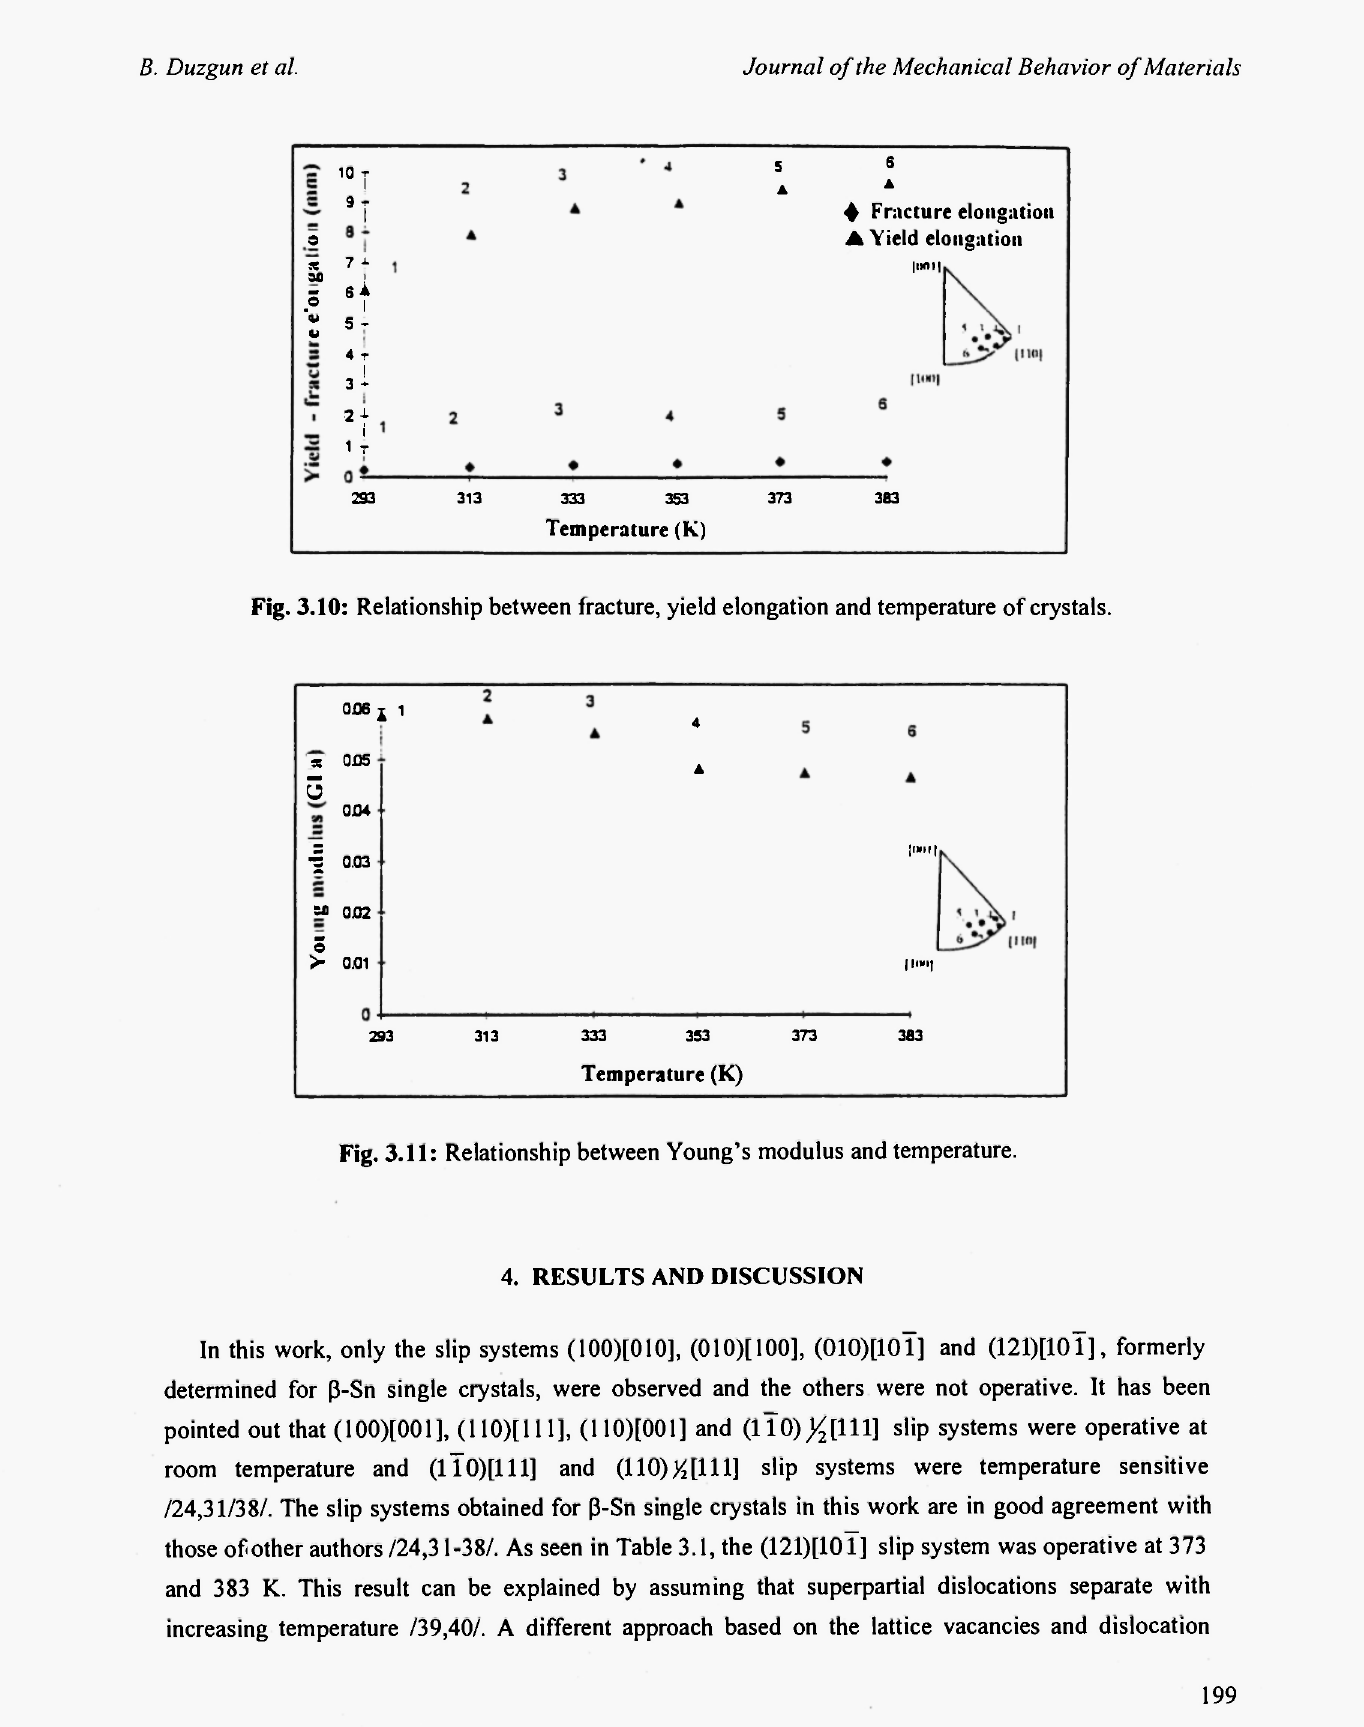
Fig. 3.11: Relationship between Young's modulus and